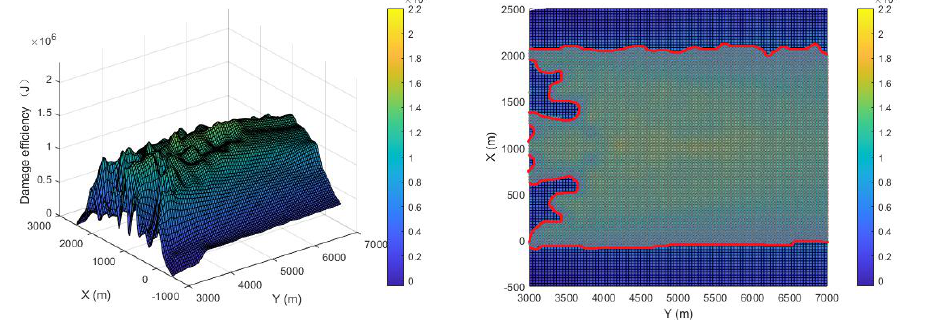
Figure 12. Damage efficiency of proposed strategy.